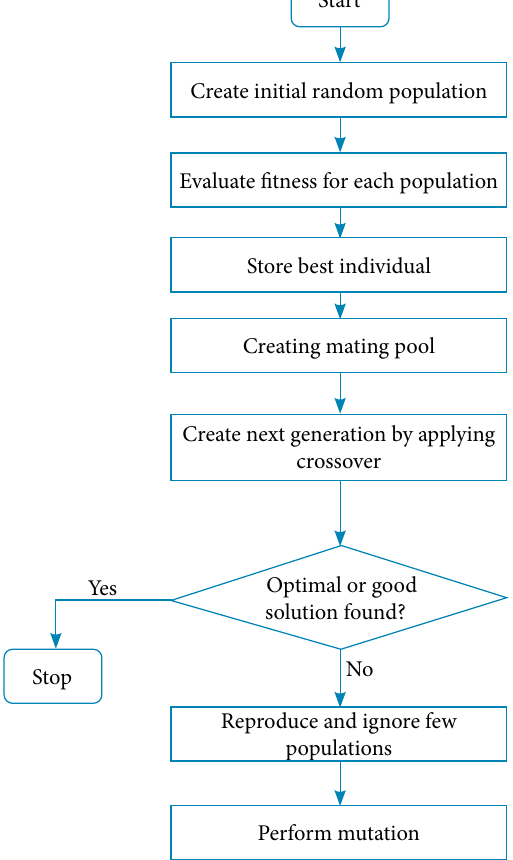
Figure 3. Flowchart of GA (Karsli and Tekinalp, 2005).